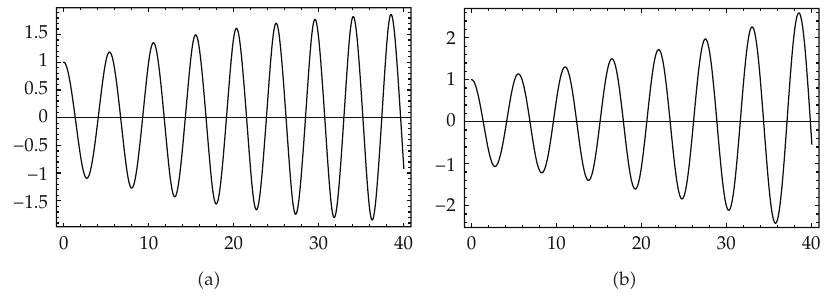
Figure 2: Plots of the Du ffi ng-van der pol equation: (cid:8) a (cid:9) RK4, (cid:8) b (cid:9) present method.